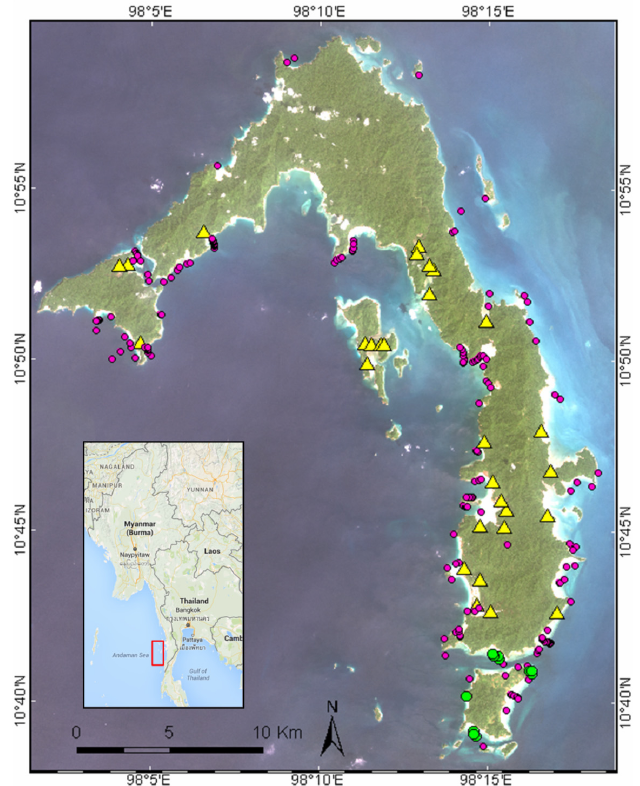
Figure 1. Study area with location of fieldwork activities performed from 28 February to 4 March 2015. Pink dots show the 152 stations investigated in the marine survey. Yellow triangles show positions where mangroves forests have been identified. Green dots indicate the sites sampled on 28 February in the southern part of the island at the time of Landsat-8 data acquisition (used as background).